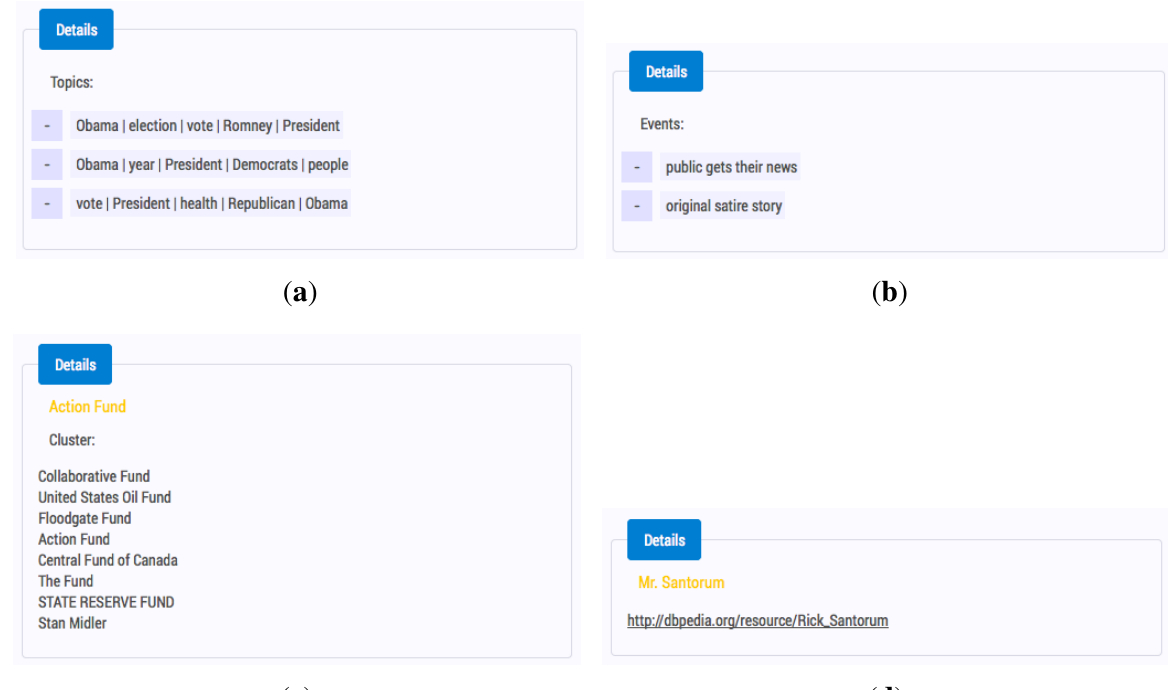
Figure 4. The detailed view on the topics, events, clusters and enrichments in